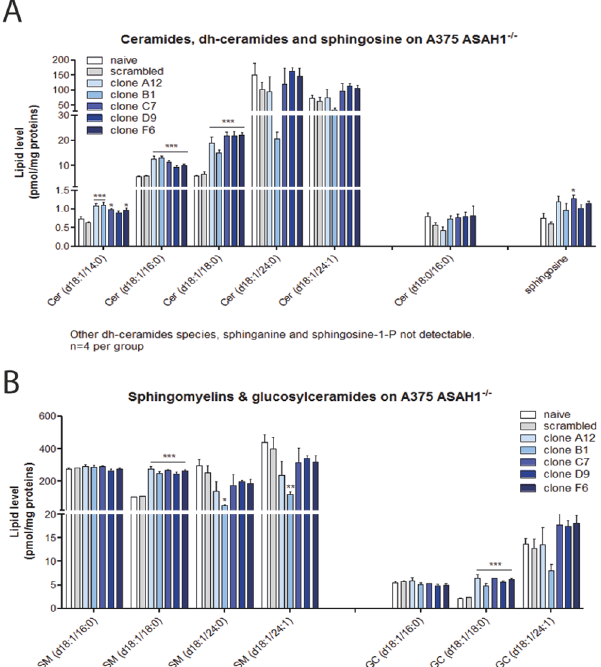
Figure 8. AC deletion alters the sphingolipidome of A375 melanoma cells. ( A ) Levels of medium-chain ceramides (C14:0, C16:0 and C18:0), dihydroceramides and sphingosine in various clones of control and ASAH1 -null cells. ( B ) Levels of sphingomyelins and glucosylceramides in the same clones. Results are expressed as mean ± SEM (n = 3), with each experiment performed in two independent groups of cells. * p < 0.05, ** p < 0.01, one-way ANOVA followed by Tukey’s test. Experiments were performed on pellets obtained 20 days after ASAH1 ablation and repeated three